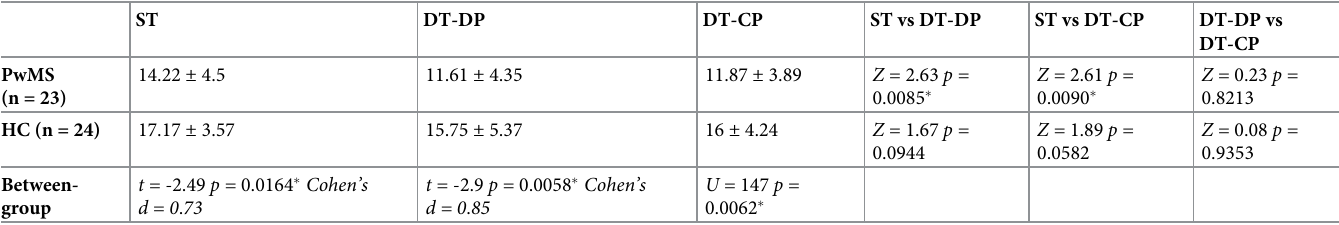
Table 4. Intragroup and between-group comparisons of direct scores of cognitive performance during DT and ST in pwMS and HC (mean ± SD). ST